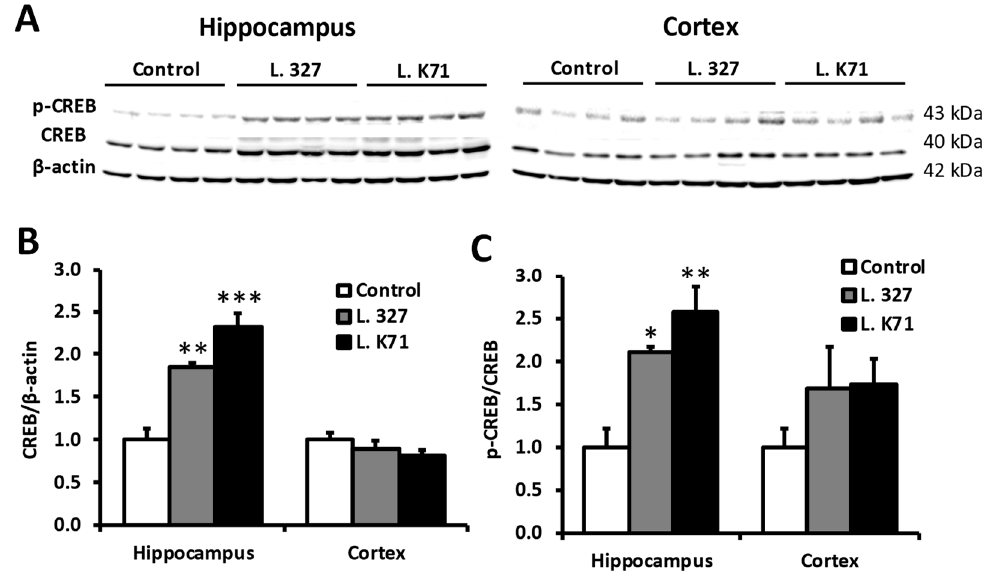
Figure 6. Representative images of BDNF immunofluorescence (green) in the hippocampal dentate gyrus (DG) and CA3 regions of SAMP8. DAPI stained nuclei (blue). Scale bar: 400 µm.